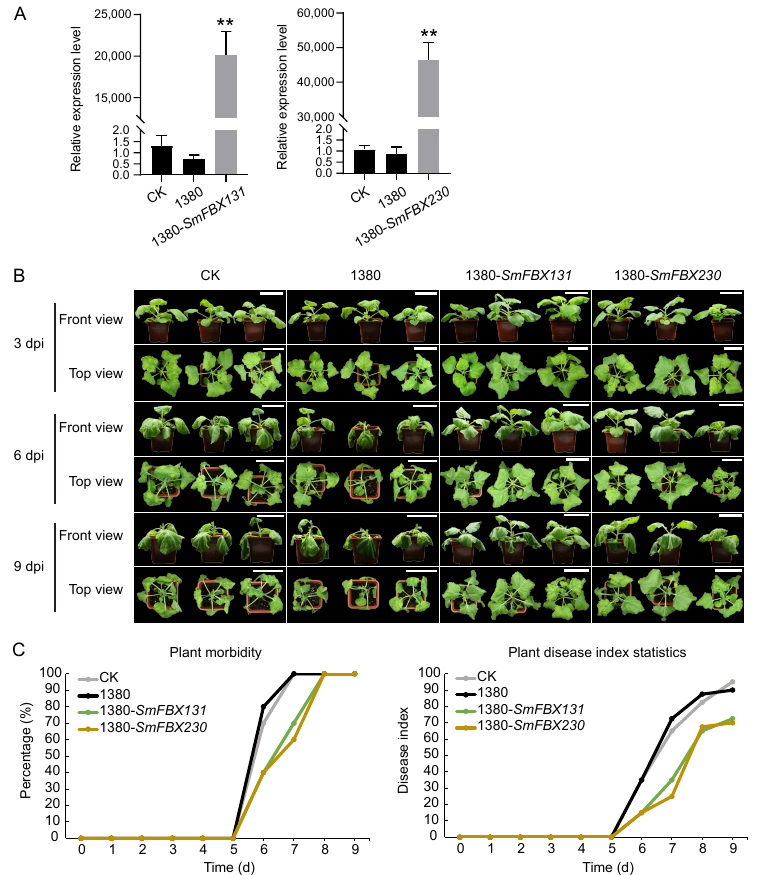
Figure 6. Transient overexpression of SmFBX131 and SmFBX230 could improve plant resistance to bacterial wilt. ( A ) The expression levels of SmFBX131 and SmFBX230 in plants. CK (control), tobacco leaves that were injected with water. 1380, tobacco plants whose leaves were injected with Agrobacterium harboring an empty vector (pCAMBIA-1380). 1380- SmFBX131 and 1380- SmFBX230 , the SmFBX131 -transient overexpression and SmFBX230 -transient overexpression plants, respectively. Data are expressed as the mean ± SEM values of three biological replicates. The method of calculation was 2 − ∆∆ ct . ** p < 0.01. Student’s t -test. ( B ) The plant phenotype after 3, 6, and 9 days of inoculation with Ralstonia solanacearum. ( C ) The plant morbidity and disease index statistics of plants after inoculation with R. solanacearum are summarized over 9 days. At least 10 biological replicates were performed. Dpi, days after inoculation; SEM, standard error of the mean. Scale bars indicate 10